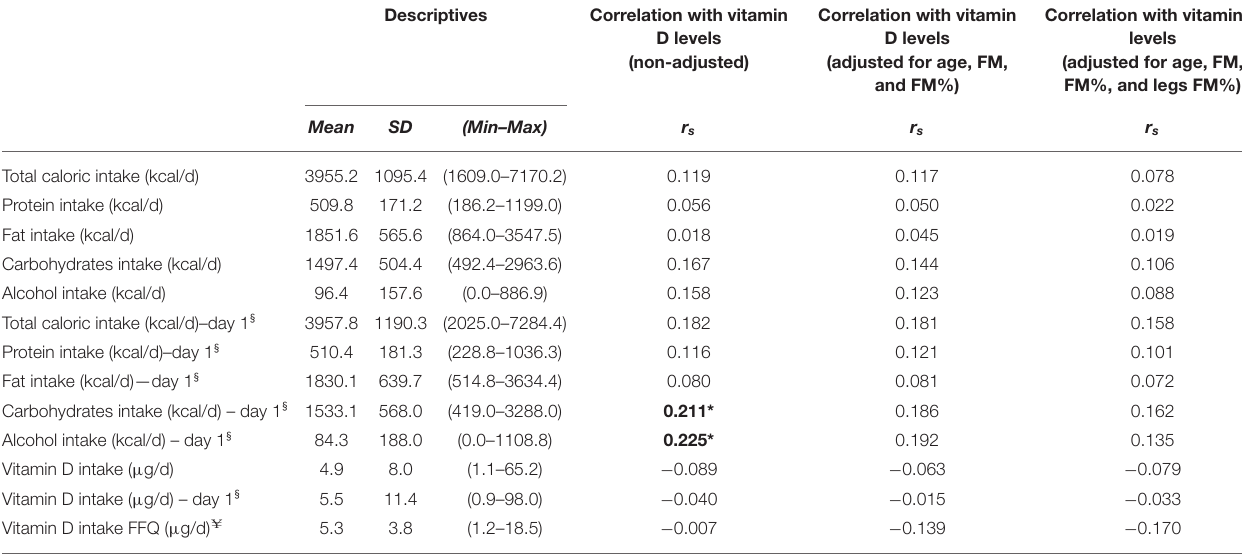
TABLE 3 | Nutritional intakes data of the studied coal miners ( N = 103, men), and correlation with serum 25 (OH) vitamin D levels.